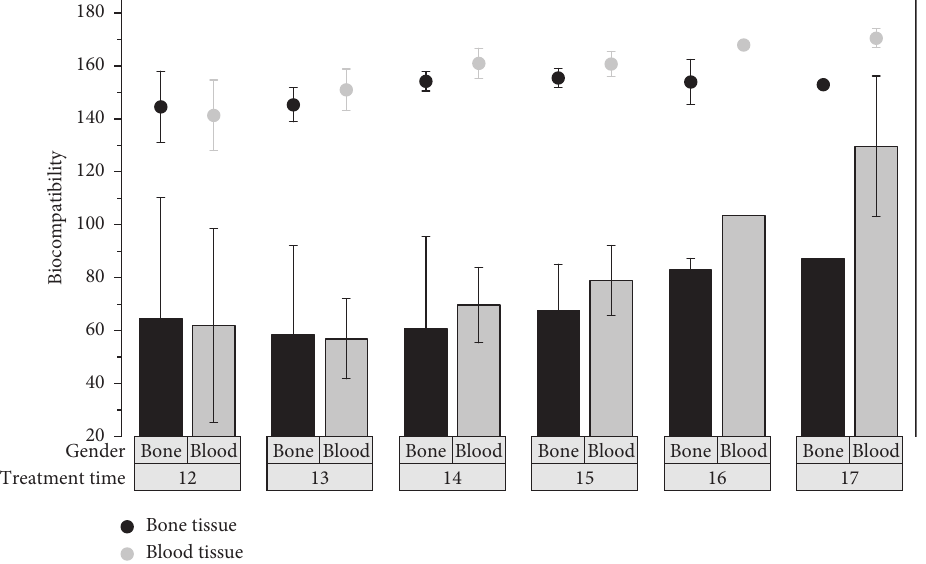
Figure 11: Biocompatibility of 3D-CT modeling to evaluate ACL and related cases in bone and blood